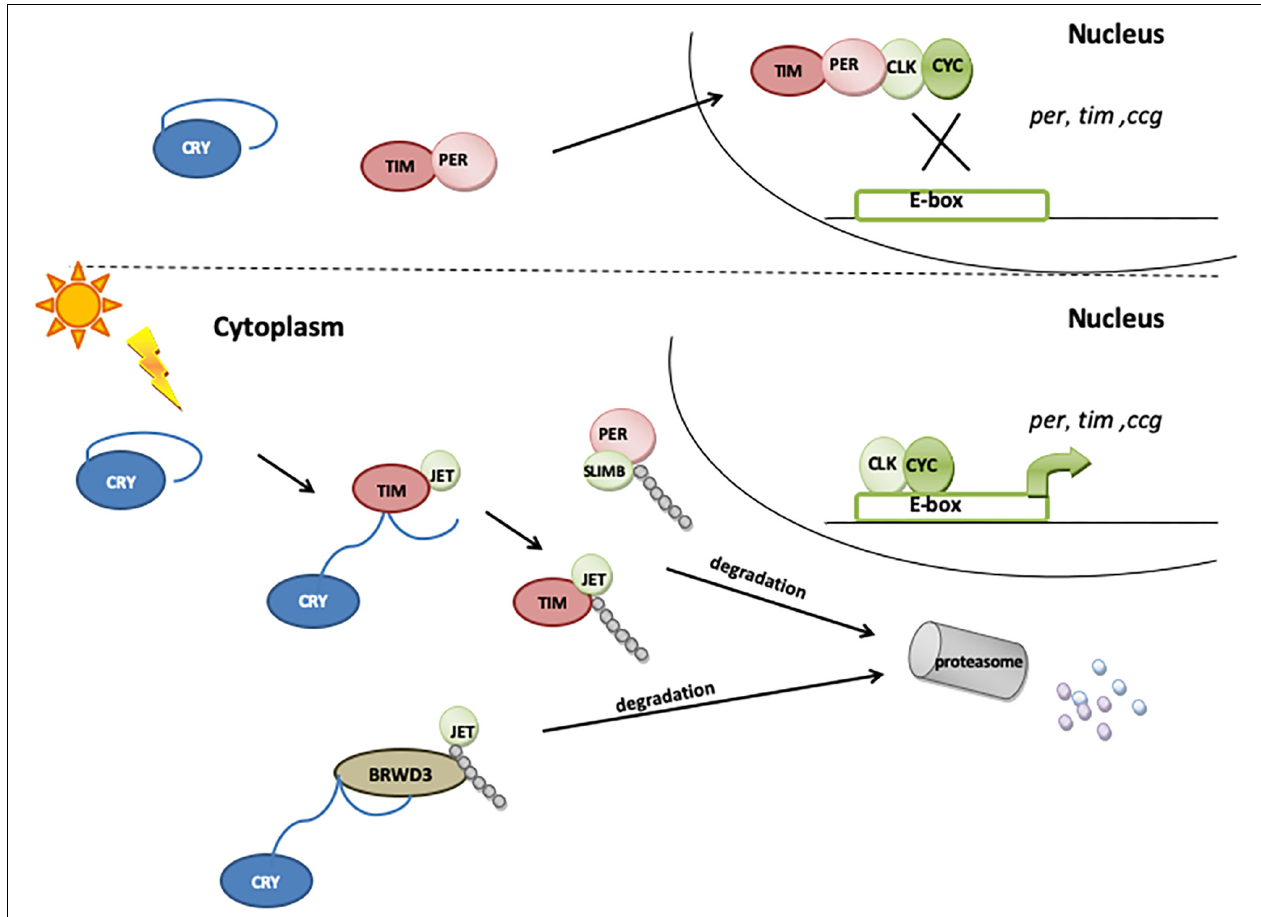
FIGURE 3 | The role of CRY in molecular clock resetting. In the presence of light, CRY binds TIM and promotes its degradation via proteasome by a mechanism that involves the F-box protein JETLAG (JET). When exposed to light, CRY also becomes a substrate for JET and for Ramshackle (BRWD3), which initiates its ubiquitination and degradation in